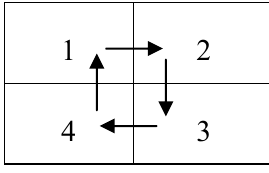
Figure 5. Quadrants of the Original LOQ